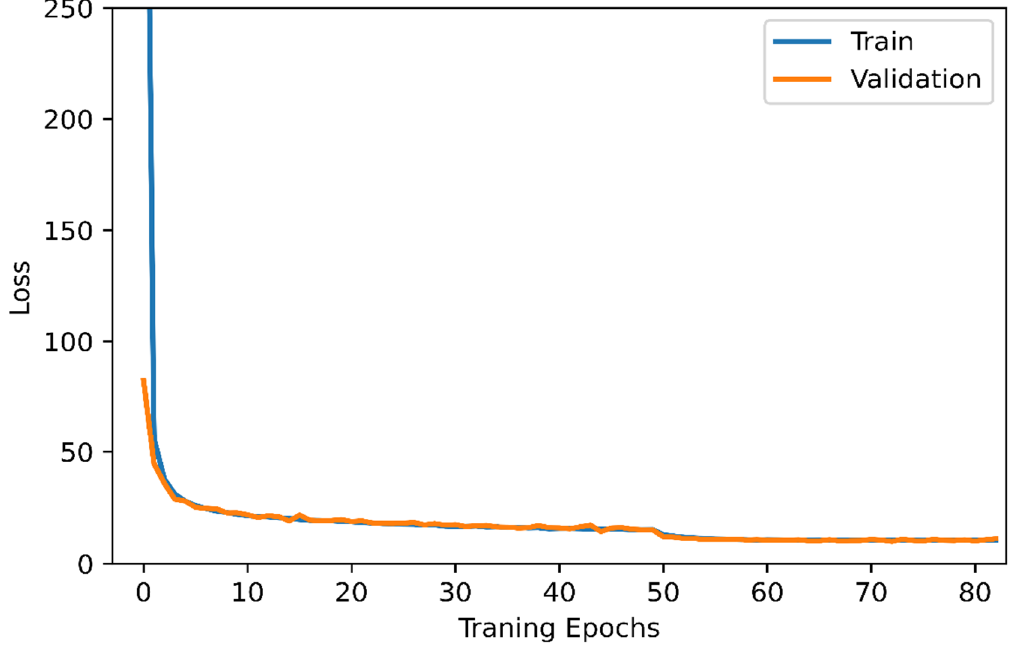
Figure 6. The training effort of the proposed YOLOv3 to develop the deep learning model.